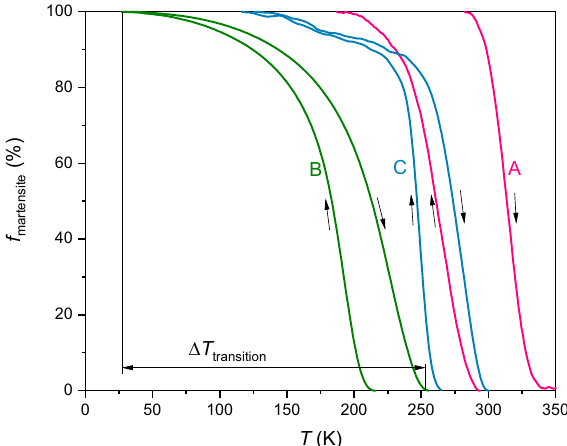
Figure 3. Fraction of martensitic volume f martensite for sample A on MgO(001), sample B on MgO(11 0) and sample C on Al 2 O 3 (0001) as a function of temperature for the cooling and heating branch. f martensite was calculated with Equation (1) from resistivity measurements at a constant external magnetic field of µ 0 H ext = 2T. Arrows indicate the measurement directions. The transition width ∆ T transition is sketched for sample B.